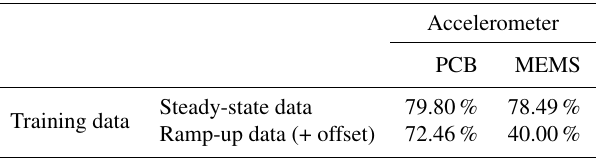
Table 13. Confusion matrix for 1500rpm PCB data and the top three features, classifier trained with ramp-up data, with an addi- tional offset in the steady-state validation data.